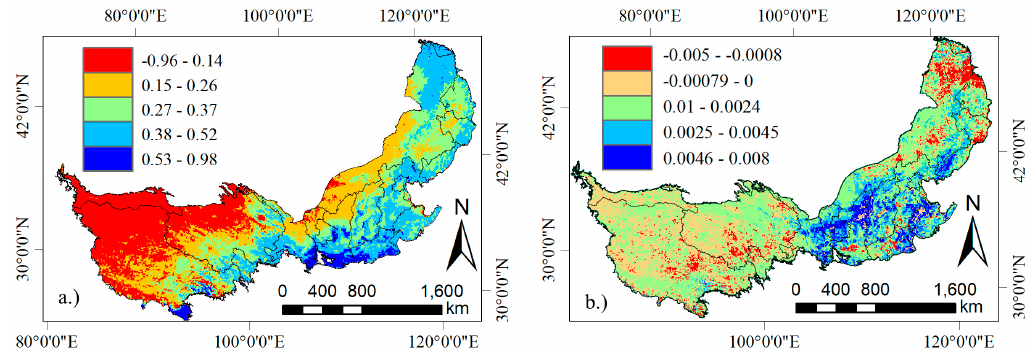
Figure 7. Spatial distribution of NDVI values under the impacts of climatic change ( a ) and human activities ( b ) from 1982 – 2015.